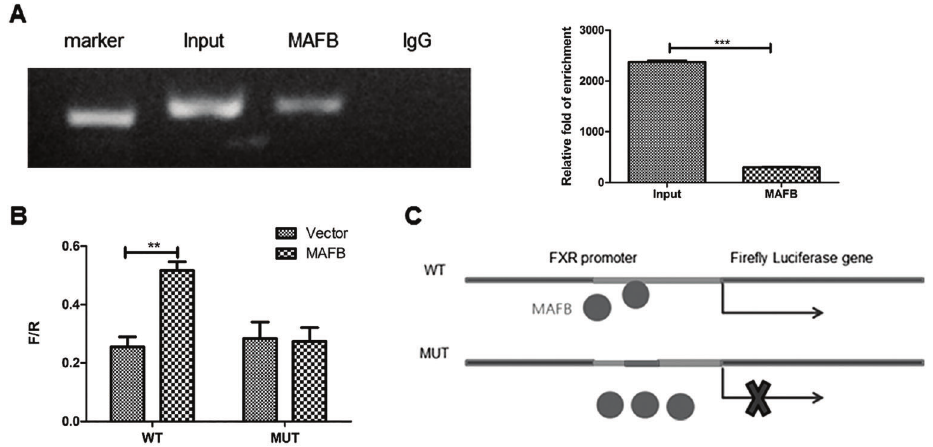
Figure 6. A , The binding of MAFB with FXR promoter was analyzed by Chip assay using antibodies against MAFB protein (left), and statistical analysis was based on data from three biological replicates (right). IgG was used as the negative control. B, Activation of FXR gene expression by MAFB binding by luciferase reporter assay. C, Schematic demonstration of the luciferase reporter assay. MAFB: musculoaponeurotic fi brosarcoma oncogene family; F/R: Fire fl y luciferase/Ranilla luciferase; WT: wild type; MUT: mutant; FXR: farnesoid X receptor. Data are reported as means ± SD. **P o 0.01, ***P o 0.001 ( t